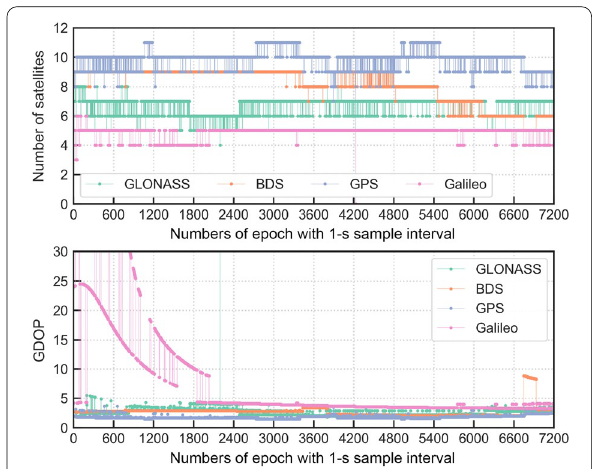
Table 3 2D positioning deviations of Huawei Mate